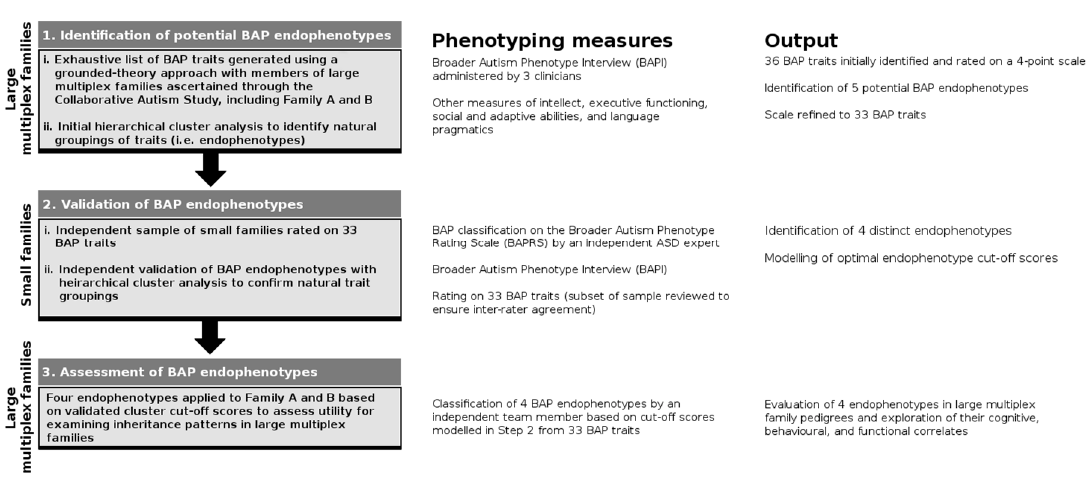
Figure 4. Iterative process used to identify and assess BAP endophenotypes. Step 1: An exhaustive list of BAP traits was generated through detailed clinical assessment of a number of large multiplex families, resulting in the identification of a final set of 33 BAP traits. Step 2. Validation analyses in an independent and aggregated sample of small families resulted in a 4-cluster solution representing distinct BAP endophenotypes. Step 3. Cut-o ff scores modelled in Step 2 were independently applied to large multiplex Family A and B for endophenotype classification and assessment of inheritance patterns.